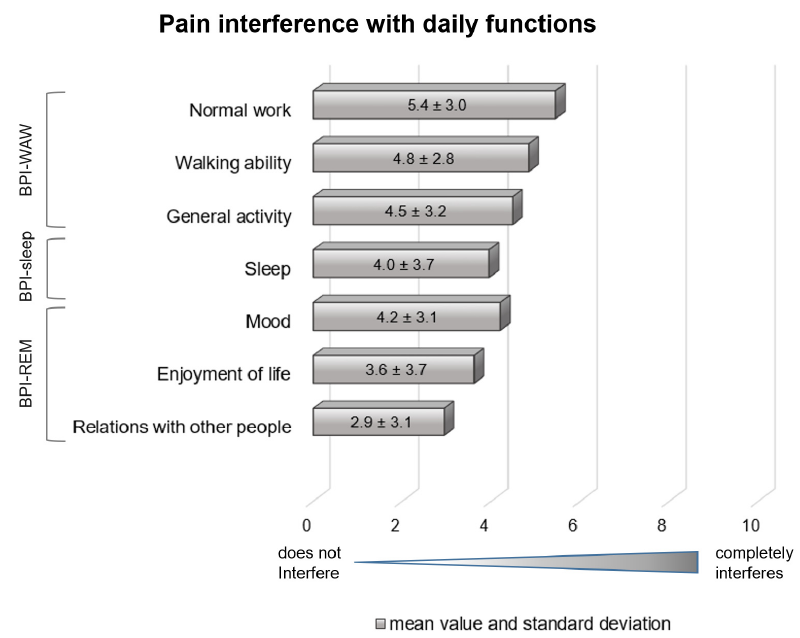
Figure 4. Daily functions impaired by pain, indicating the mean values on a scale from 0 (=does not interfere) to 10 (=completely interferes). The items are arranged within the respective BPI subdimensions of pain interference in descending order of the mean values. BPI = Brief Pain Inventory; REM = affective subdimension of the BPI; WAW = activity subdimension of the BPI.